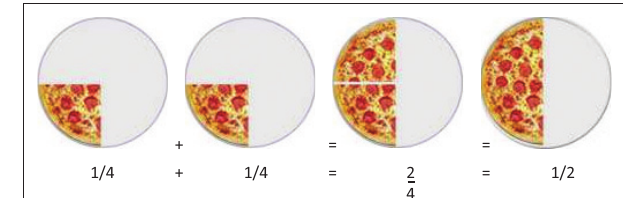
FIGURE 2: Addition and subtraction of